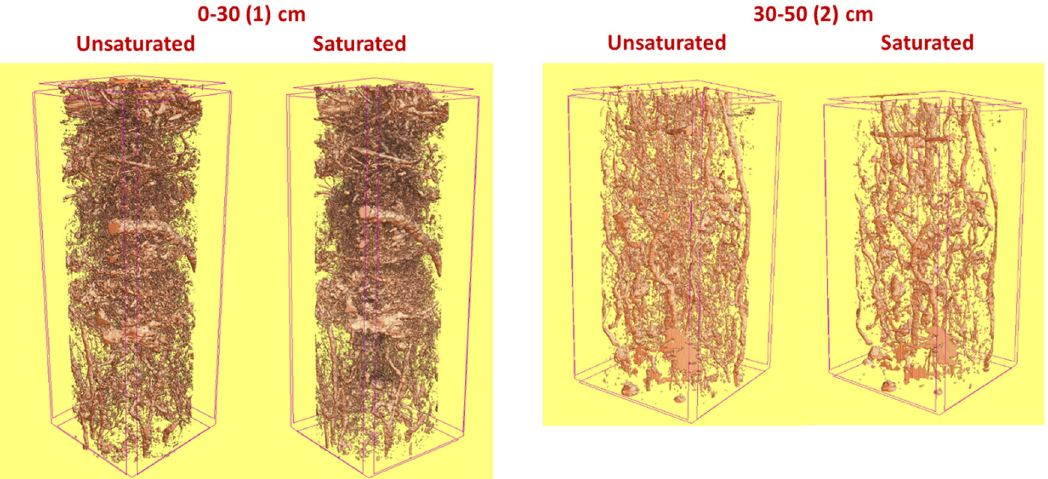
Figure 3: Three - dimensional pore space models before and after saturation.